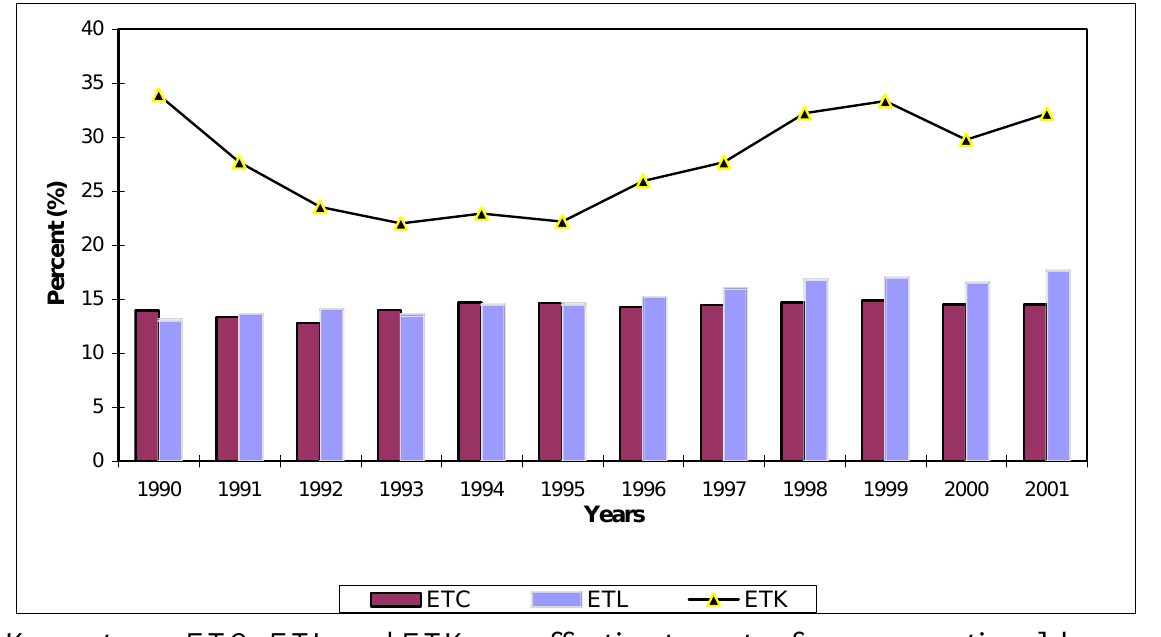
Effective tax rates of consumption, labour and capital: South Africa,